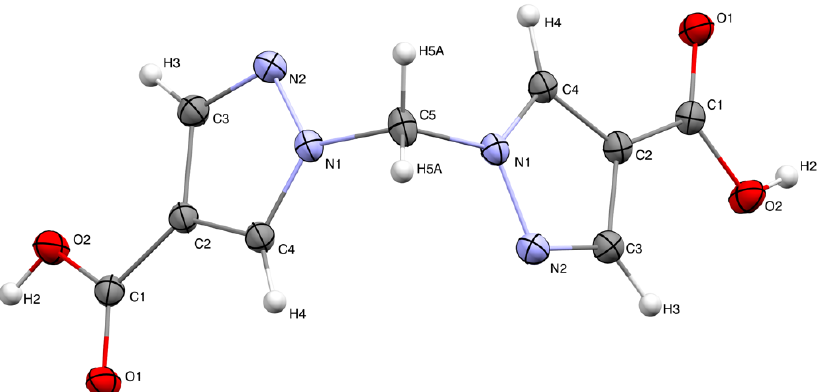
Figure 1. Molecular structure of H 2 bpmdc; thermal ellipsoids are drawn at the 50% probability level.